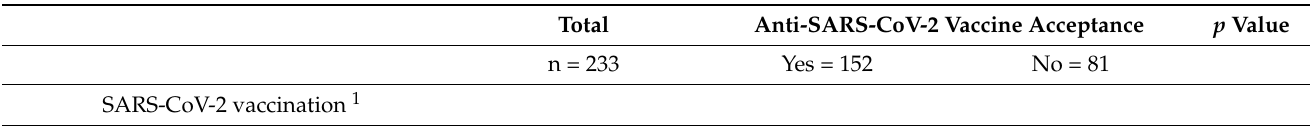
Table 2. Vaccination and Health Belief Model characteristics of the pregnant women by anti-SARS- CoV-2 vaccine